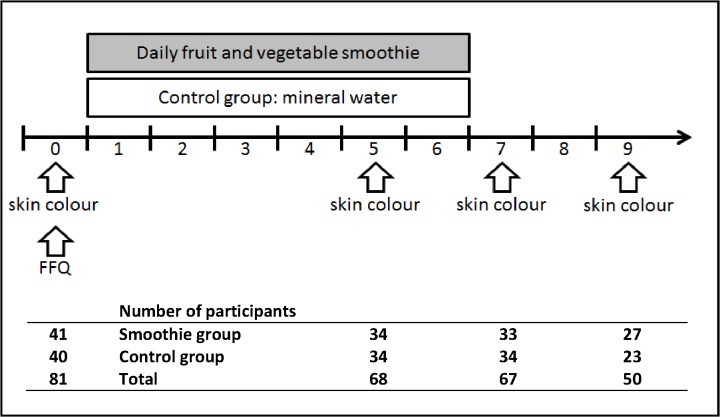
Study design and participant attrition.Considering total carotenoid and calorie intake in baseline diet, participants were assigned into intervention or control group by block randomization. Participants received either a smoothie or water every weekday for 6 weeks, and skin color was measured at baseline and in weeks 5, 7 and 9. 80.5% of the participants in the smoothie group and 85% of the participants in the control group completed the intervention.